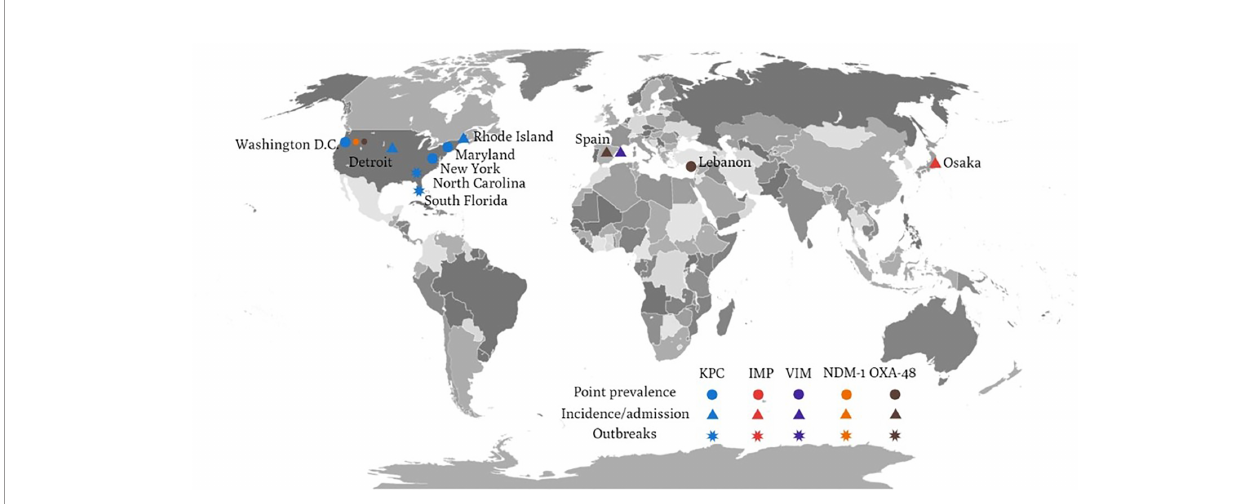
FIGURE 1 | The global distribution of various carbapenemase-producing Enterobacteriaceae related to long-term care